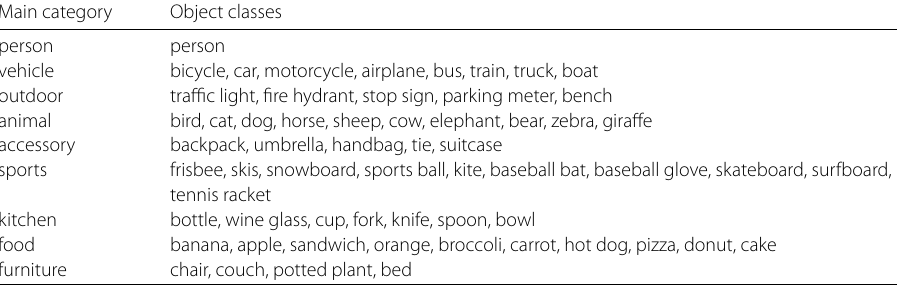
Table 15 A list of the main categories and their corresponding object categories of the COCO training dataset from